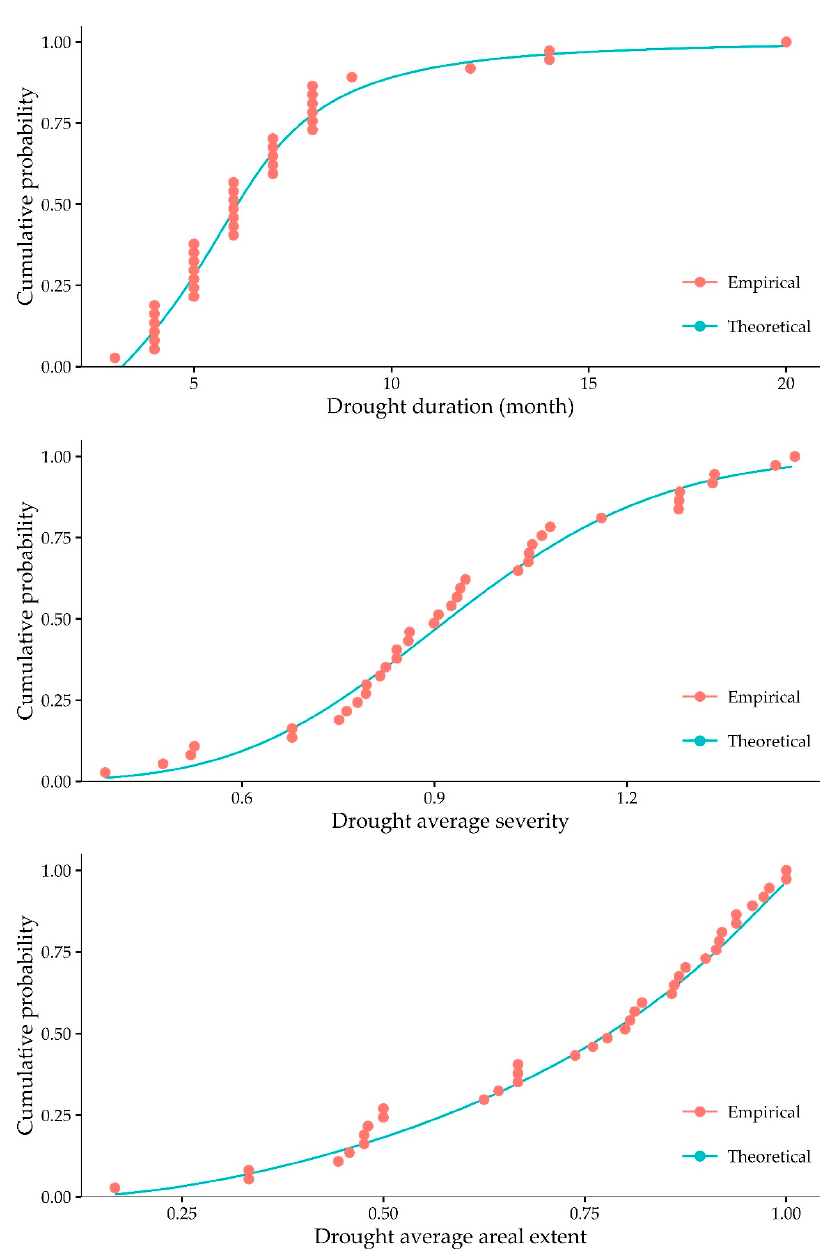
Figure 3. Empirical and theoretical univariate CDF of drought characteristics LD, S, and A. The theoretical CDF values in the top (LD), middle (S), and bottom (A) panels are calculated using Wakeby, Pearson 5, and Johnson SB distributions, respectively.